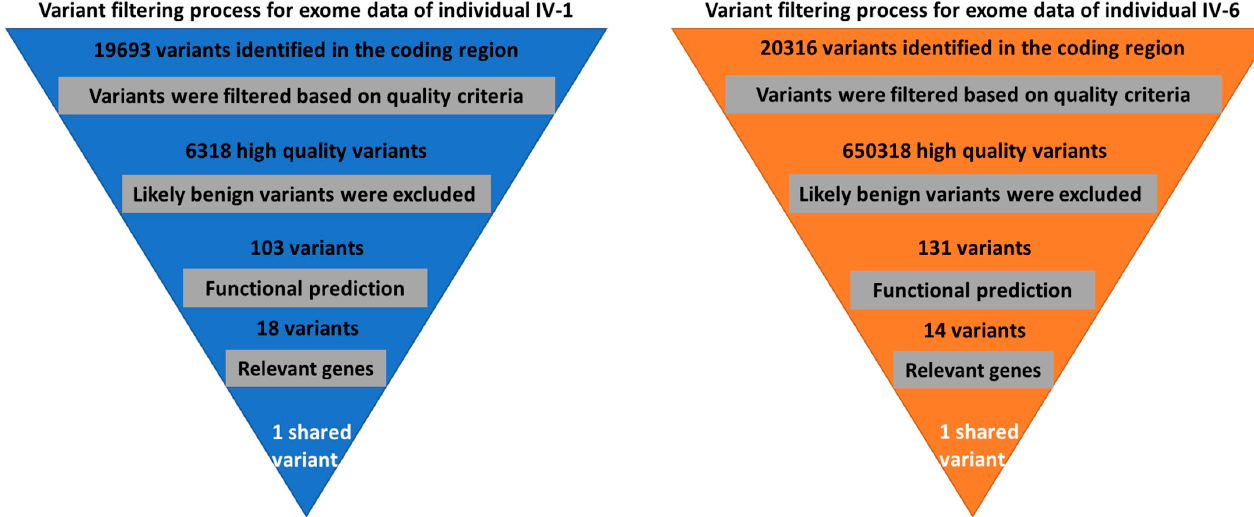
Figure 2. Variant filtration scheme for the exome data of two affected individuals. A single shared homozygous variant has been detected using this